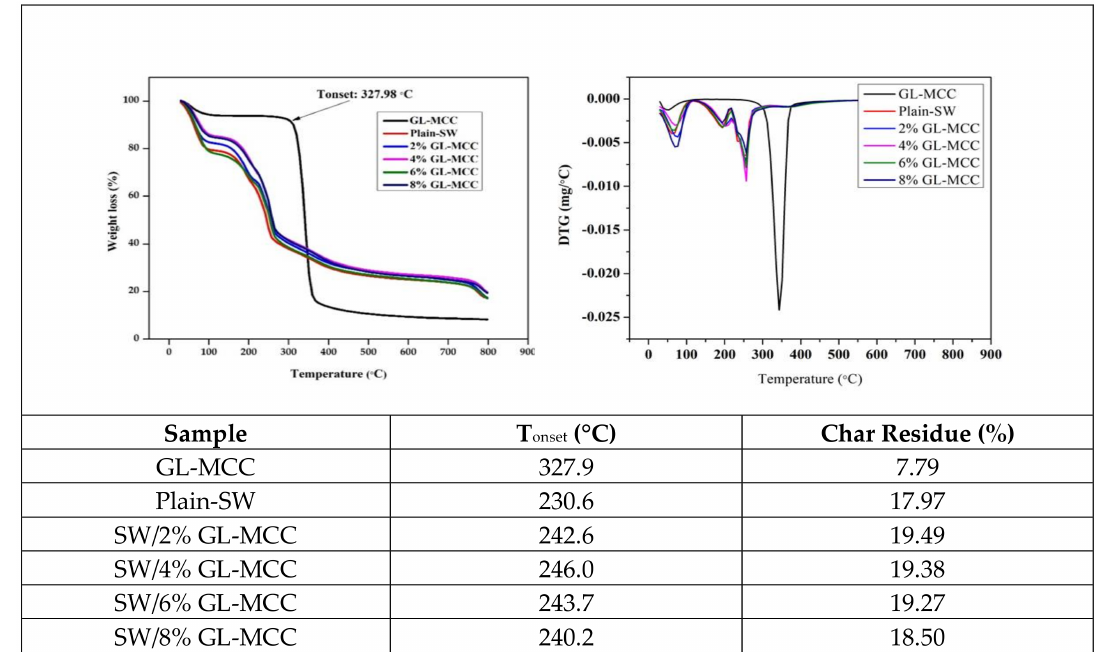
Figure 5. Thermal properties of GL-MCC and macroalgae (SW) / polysaccharide microfibre (GL-MCC) biopolymer